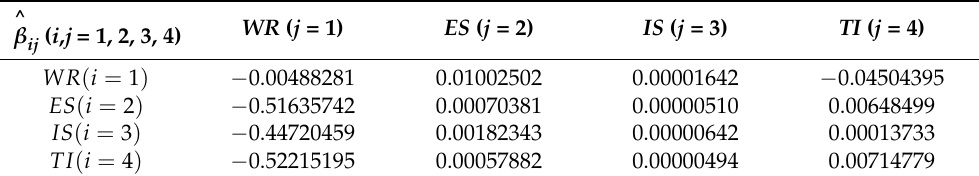
Table 13. GLV model related parameters of forecast data in Hebei area.